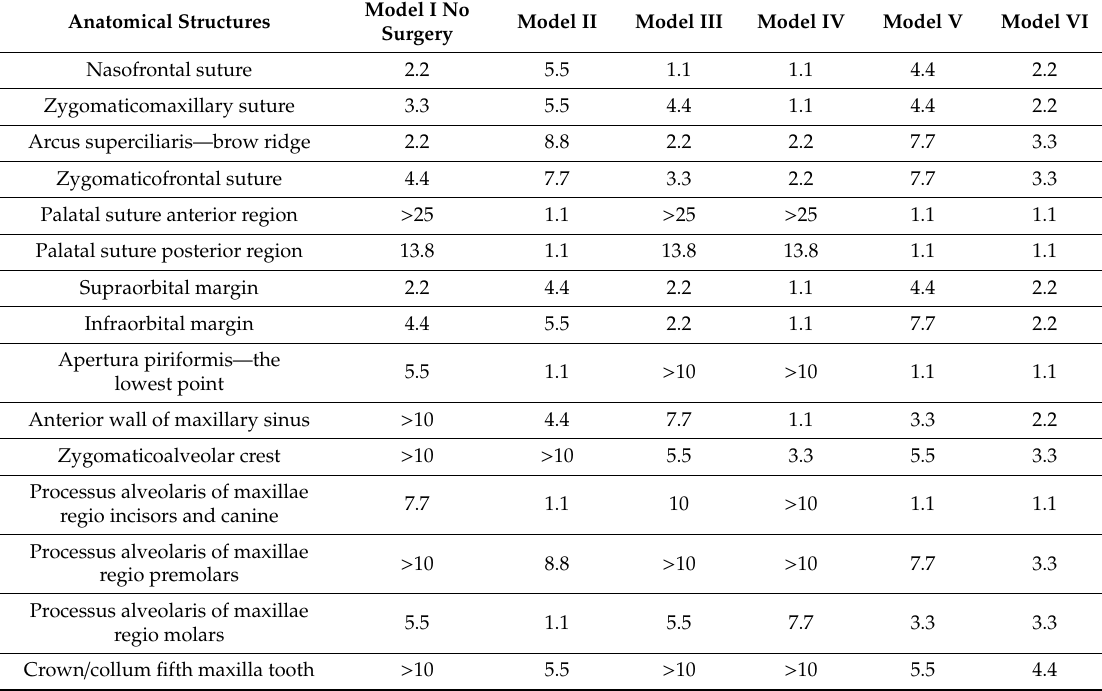
Table 3. Stress distribution according to Huber on the craniofacial model (MPa) with various surgical procedures and tooth born orthodontic appliance using finite element